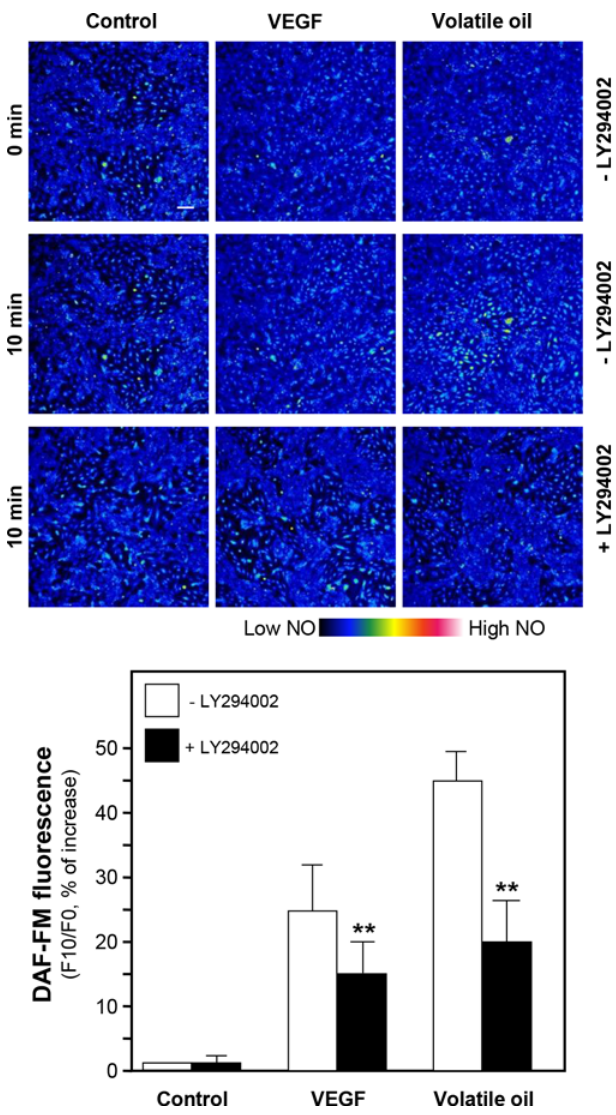
Figure 5. Volatile oil-induced NO production is blocked by LY294002. Cultured HUVECs were pre- treated with serum free medium or LY294002 (1 µ M) for 3 hours, and then labeled with fluorescent NO indicator DAF-FM DA for 30 min. Fluorimetric measurement was performed after the treatment of NRR volatile oil (25 µ g/mL), VEGF (100 ng/mL, positive control). The amounts of NO were evaluated by measuring the fluorescence intensity (upper panel). Micrographs were taken by the confocal microscope. Bar = 100 µ m (upper panel). Quantification of NO production was displayed as a ratio of fluorescence intensity at 10 min (F10) to the control at time 0 (F0) in the cultures (lower panel). Mean ± SEM, n = 3, each with triplicate samples. ** p < 0.01.